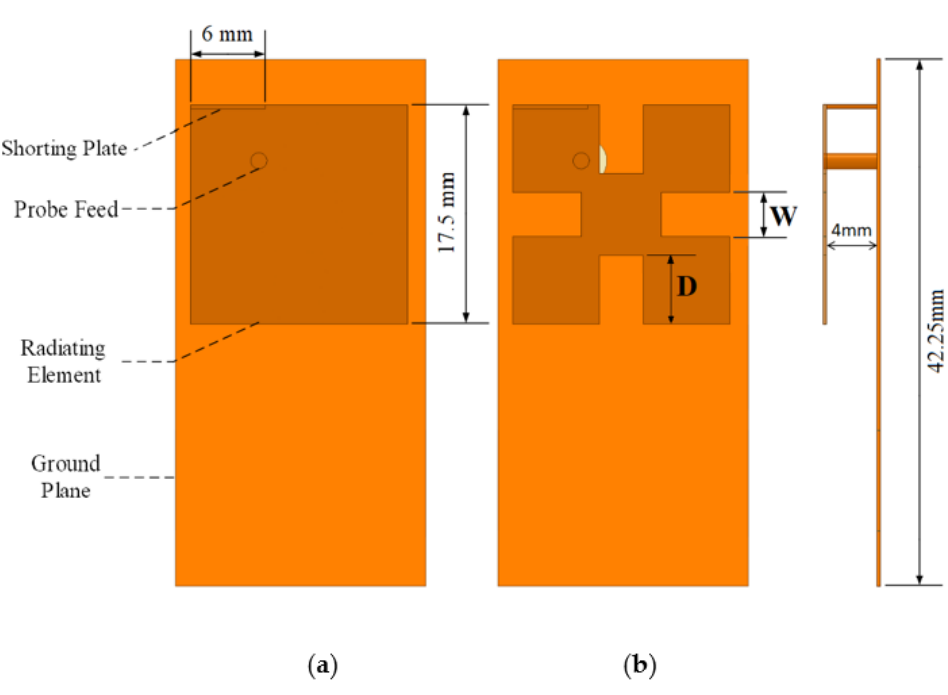
Figure 1. ( a ) Conventional square-shaped PIFA element, and ( b ) Minkowski pre-fractal-shaped PIFA element.